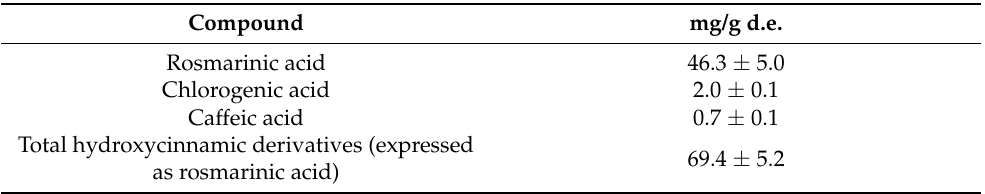
Figure 1. HPLC-DAD analysis of Ro ex recorded at 280 nm. Rosmarinic acid is the phenolic compound of the extract with the highest content; other hydroxycinnamic derivatives are present in high concentration. Table 2. Content of rosmarinic, chlorogenic and caffeic acid, and total hydroxycinnamic derivatives, expressed as mg of rosmarinic acid/g of d.e.